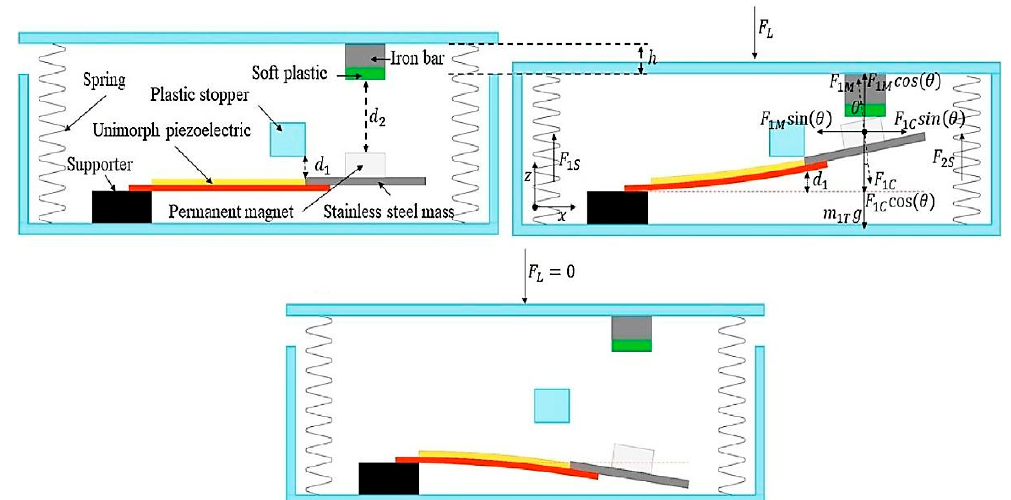
Figure 14. Example of Frequency-up converter [35].